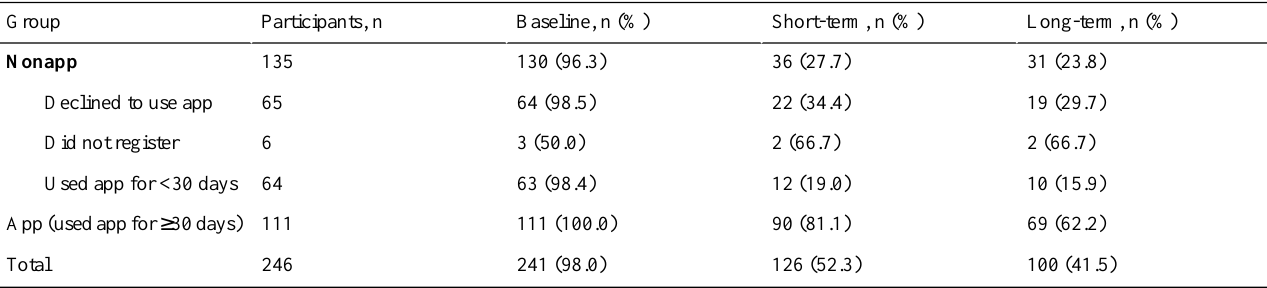
Table 2. Number of participants with questionnaire responses at the short-term follow-up (prior to 4.5 months from baseline) and the long-term follow-up (between 4.5 and 7 months from baseline).